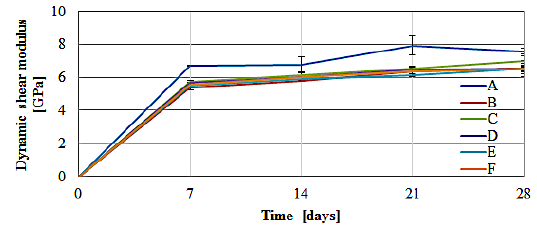
Figure 3. Development of the dynamic shear modulus for the samples.